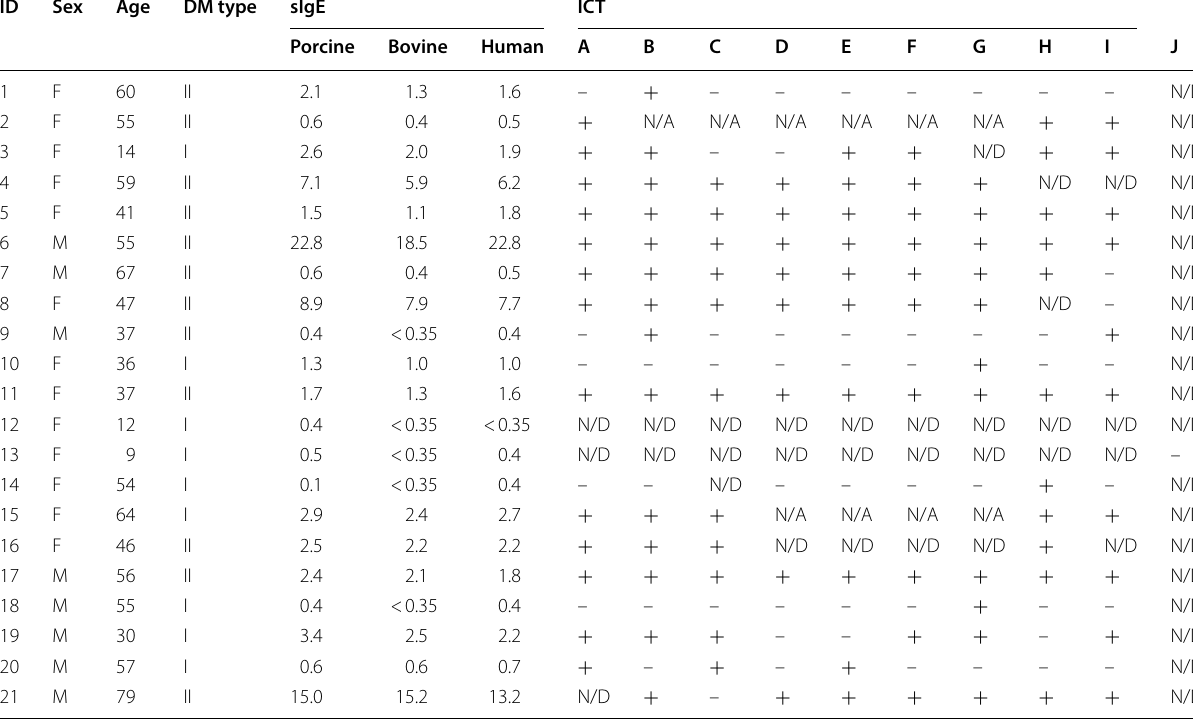
Table 1 Demographics and test results